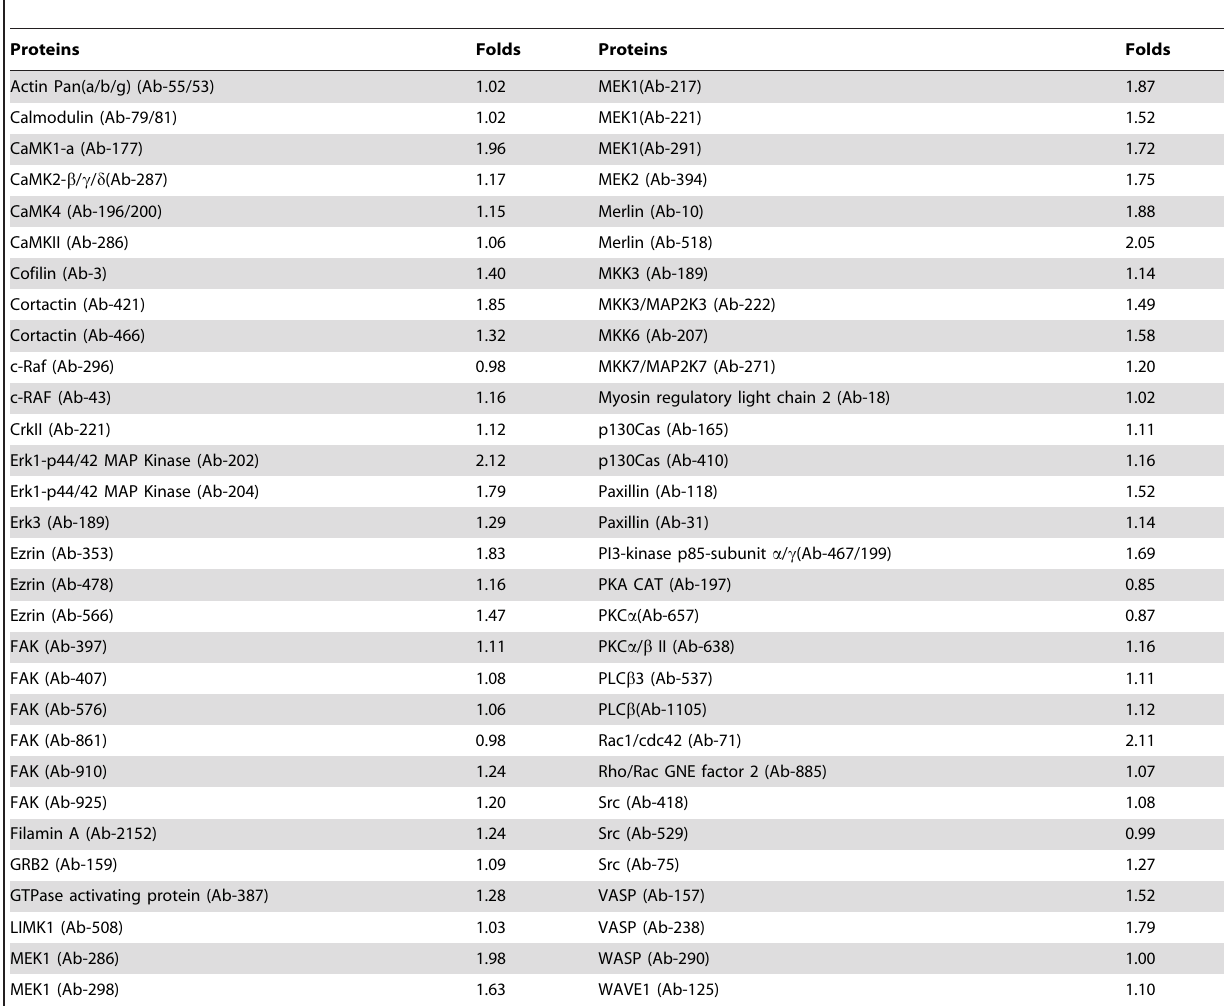
Table 1. Phosphorylation levels of 60 selected proteins related to cell migration were detected by a Full Moon Cytoskeleton II Phosphorylation Antibody Array.